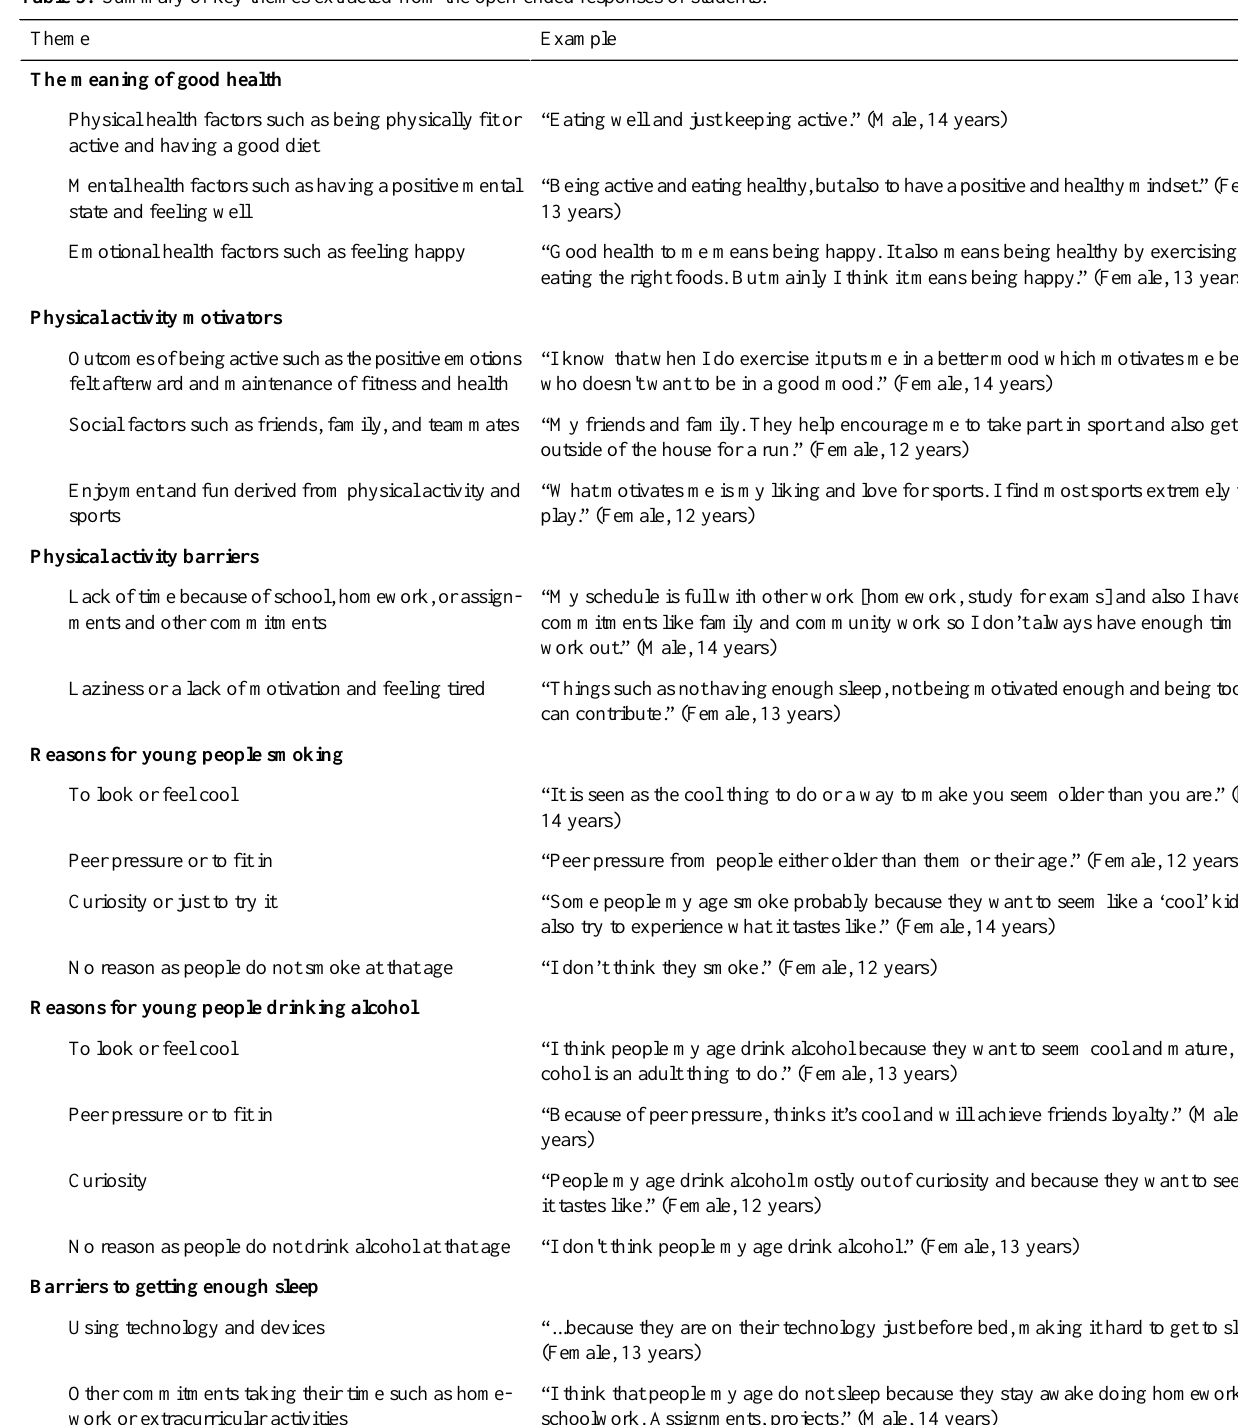
Table 3. Summary of key themes extracted from the open-ended responses of